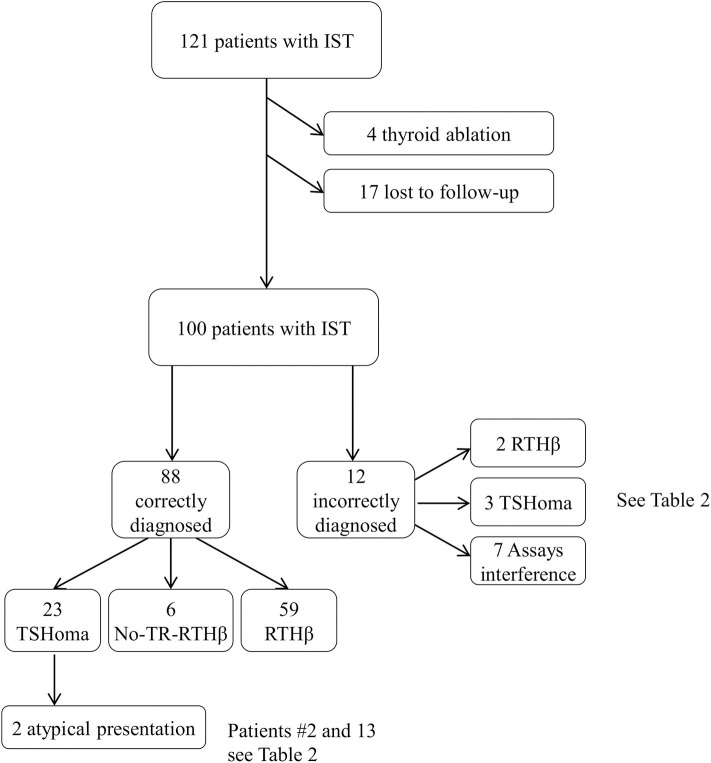
Selection process of the medical record included in this survey. Of the 121 files screened, 100 cases were included in the final analysis. See also Table 2 for further details.